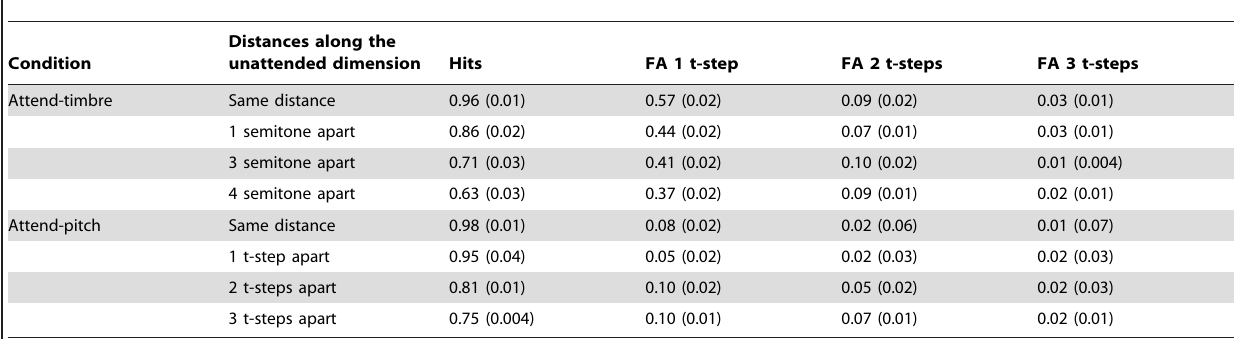
Table 1. Mean hit rate and false alarm rates for all timbre and pitch distances in the two conditions.